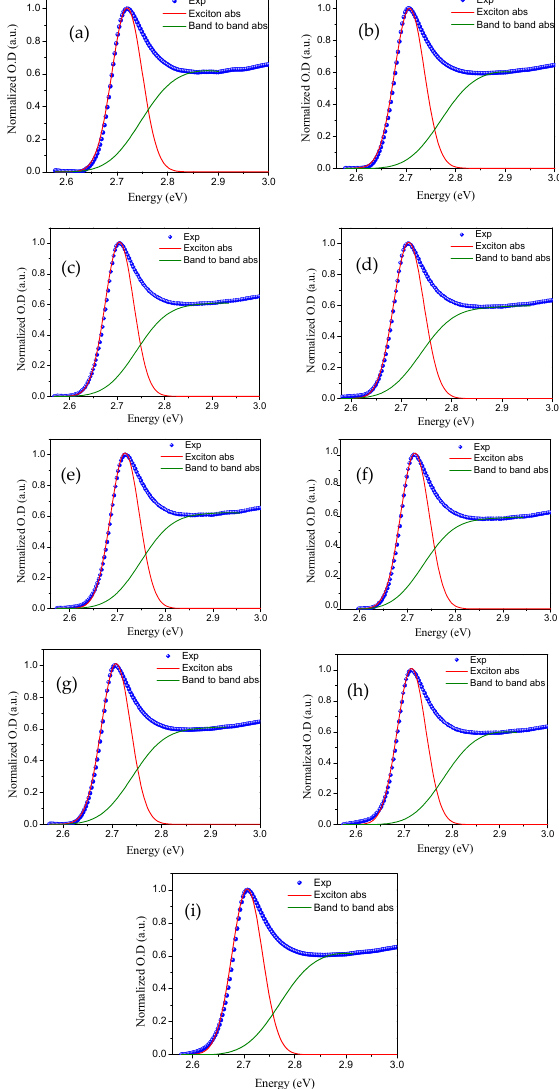
Figure 5. Excitonic and band-to-band absorption with experimental data for CsPb(Cl 0.5 Br 0.5 ) 3 with a polymethyl methacrylate (PMMA) thickness of ( a ) 0 nm, ( b ) 0 nm_sol, ( c ) 25 nm, ( d ) 50 nm, ( e ) 100 nm, ( f ) 200 nm, ( g ) 300 nm, ( h ) 400 nm, and ( i ) 500 nm. The optical band gap—e.g., exciton and PL peak positions, FWHMs of the exciton, and PL of